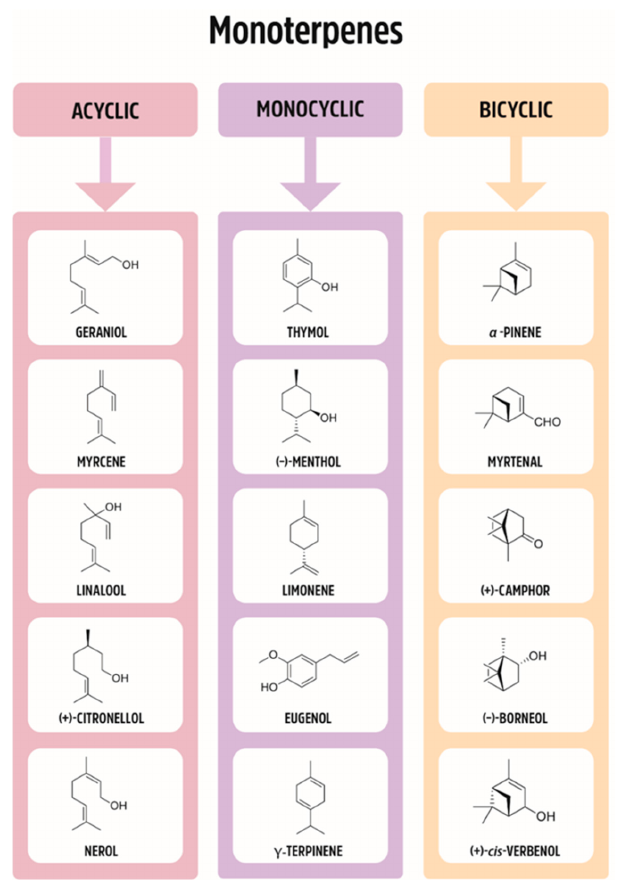
Figure 1. Division of monoterpenes (acyclic, monocyclic, bicyclic). Int. J. Mol. Sci. 2020 , 21 , x FOR PEER REVIEW